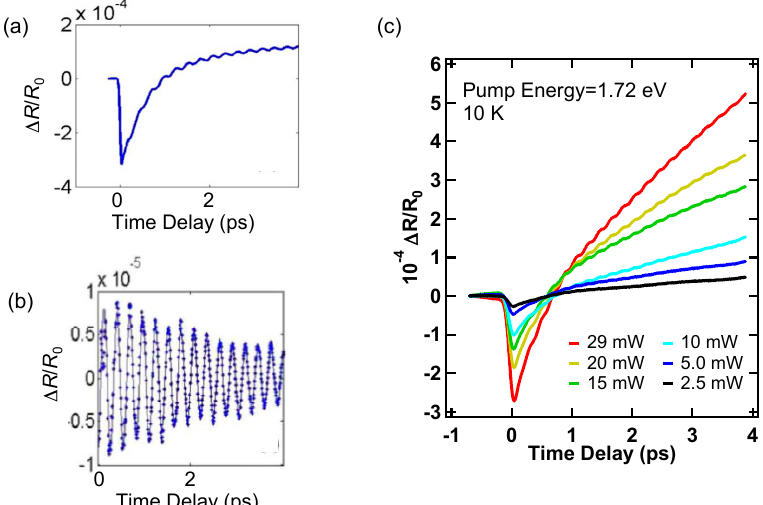
Figure 4. ( a ) ∆ R / R 0 signal in a LuMnO 3 single crystal at room temperature. ( b ) Oscillatory component of the signal in ( a ). Reprinted figures with permission from [22] Copyright (2009) by the American Physical Society. ( c ) Pump power dependence of the ∆ R / R 0 signal in the YMnO 3 thin film at the pump photon energy of 1.72 eV at 10 K.